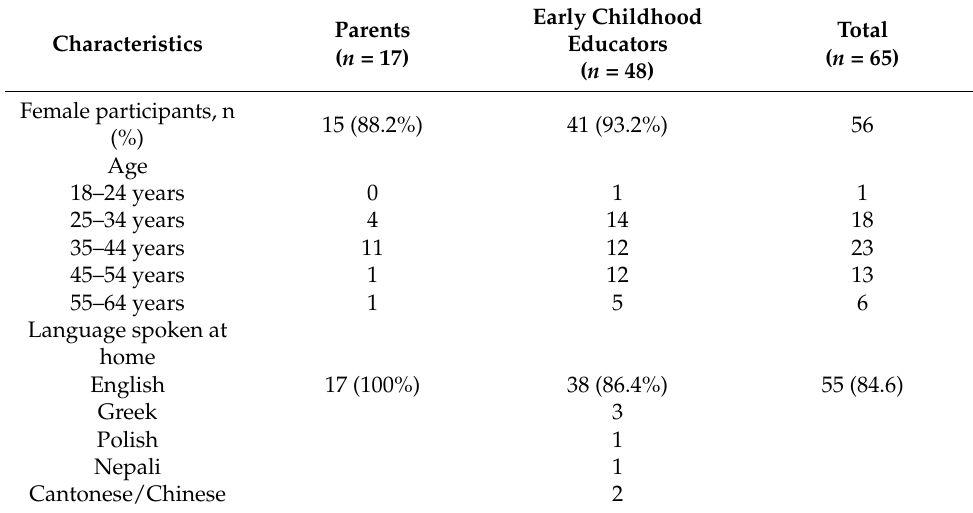
Table 3. Characteristics of study